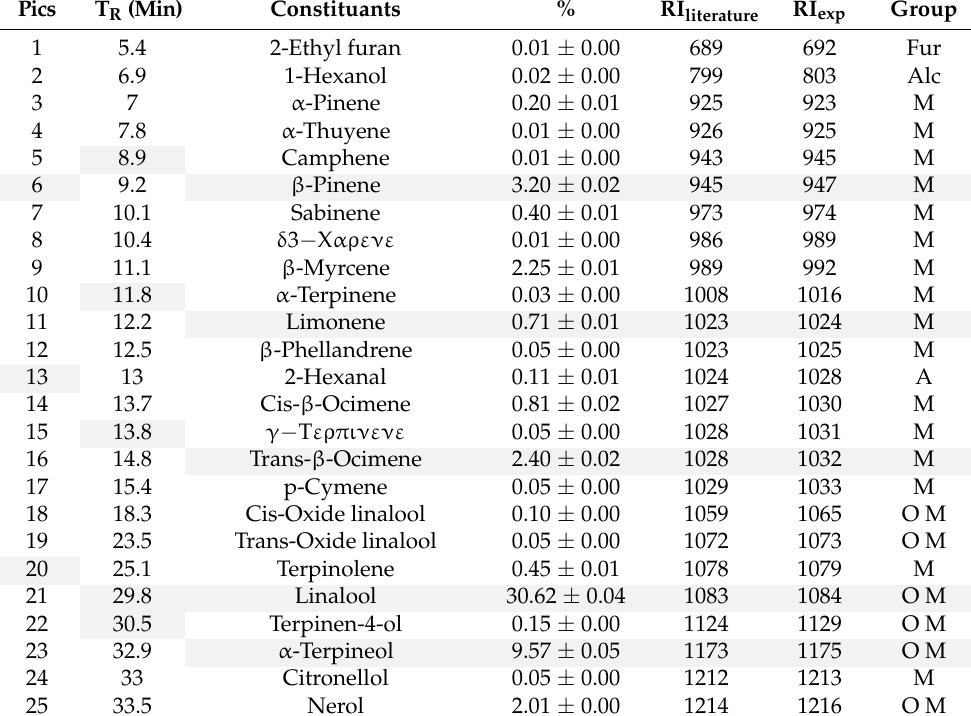
Table 1. Essential oil composition of Algerian Citrus aurantium from